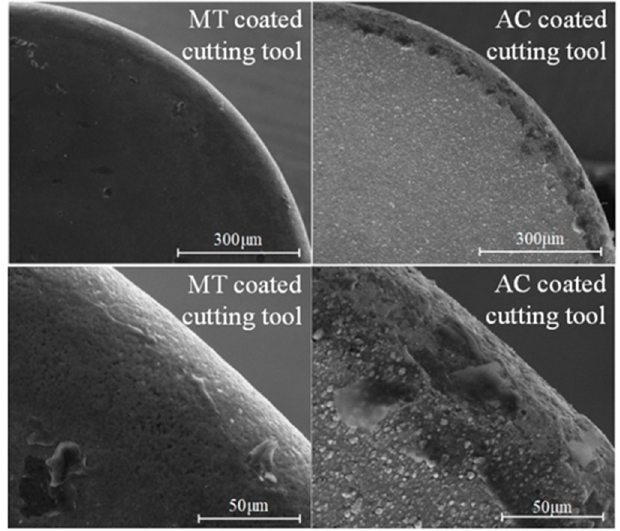
Figure 5. Rake face images of MT- and AC-coated cutting tools.